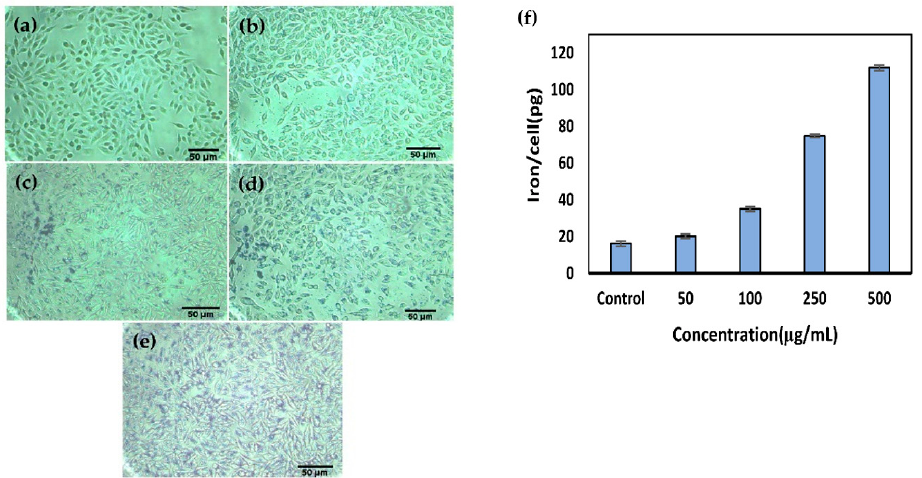
Figure 4. Prussian blue staining illustrated the density of iron oxide nanoparticles inside the MC 4 L 2 cells after 2 h incubation with ( a ) control; ( b ) 50; ( c ) 100; ( d ) 250; ( e ) 500 μ g/mL of G 4 @IONPs; the iron particles appeared as blue precipitates in the cell cytoplasm; ( f ) the cellular uptake of G 4 @IONPs at different concentrations was measured by Inductively Coupled Plasma Mass Spectrometry